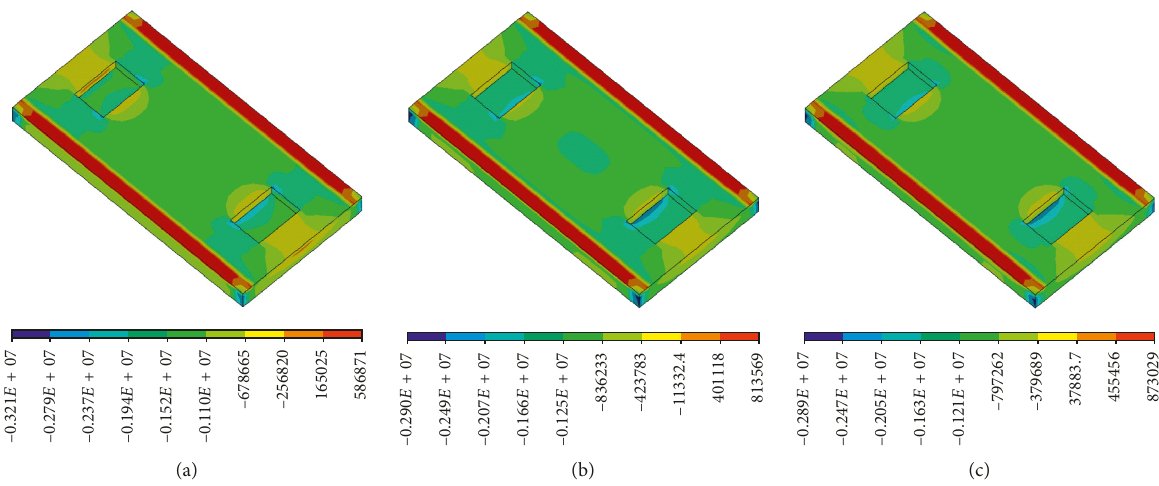
Figure 20: Longitudinal stress of the bed plate under condition 2. (a) P